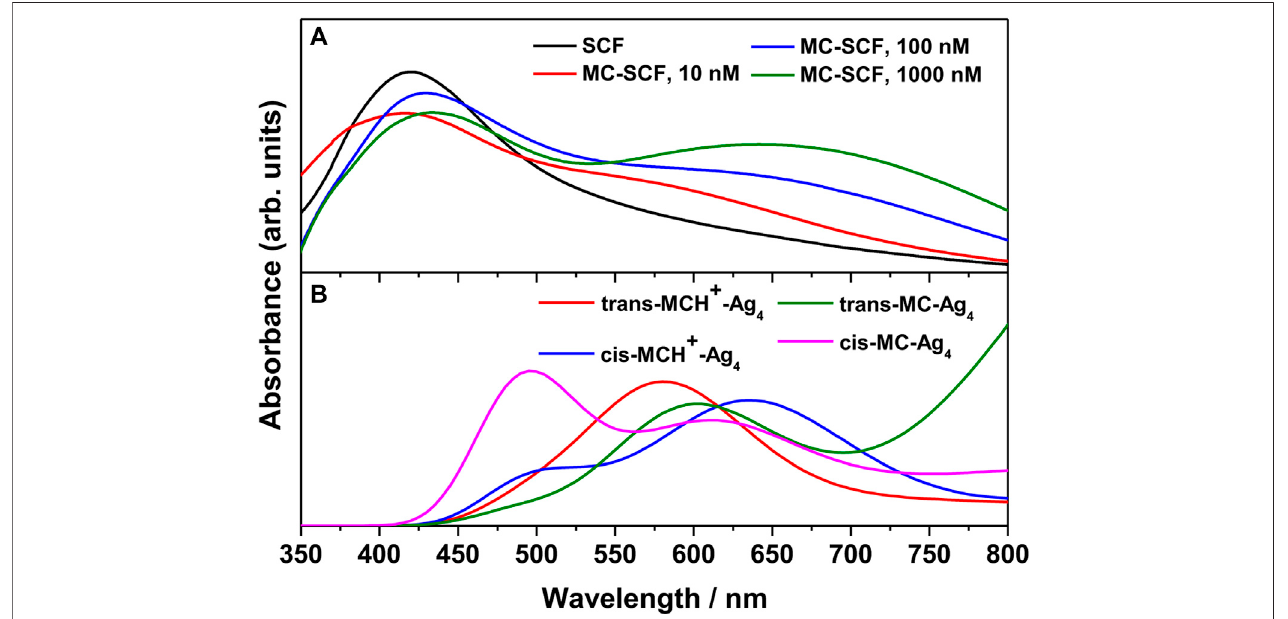
FIGURE 3 | (A) Surface plasmon resonance (SPR) bands of bare nanostructured SCF and MC-SCF with varying concentrations of MC. (B) The computed absorption spectrum of trans -MCH + -Ag 4 , cis -MCH + -Ag 4 , trans -MC-Ag 4 and cis -MC-Ag 4 complex.